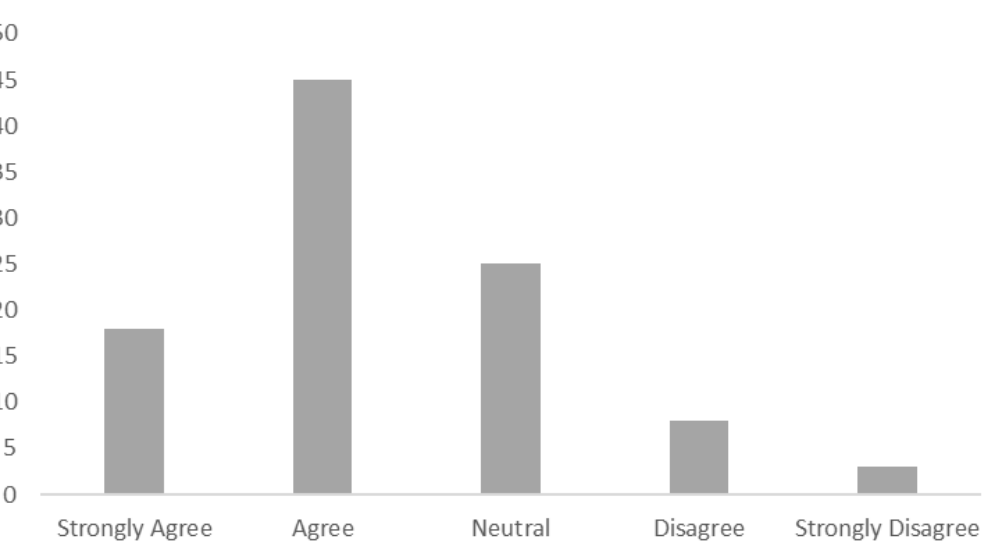
Figure 2. My lecturers make good use of the VLE